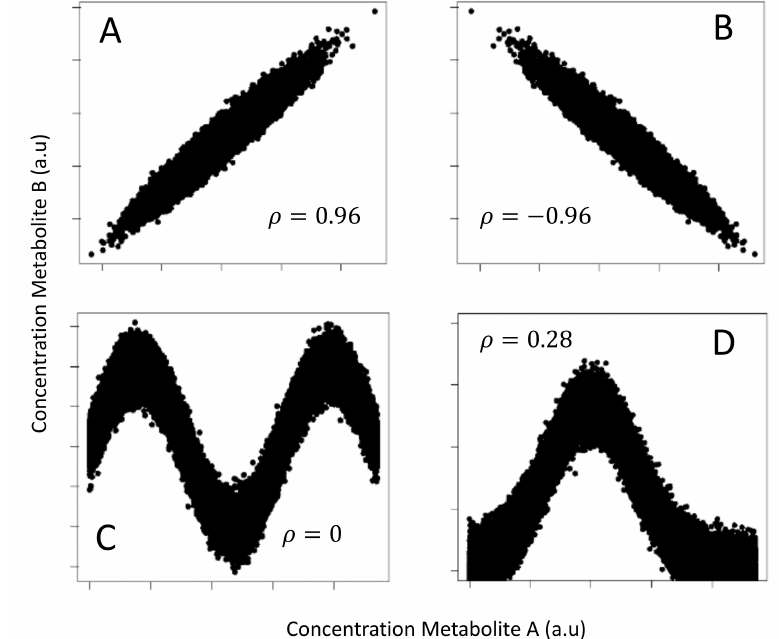
Figure 3. Four different data patterns obtained by plotting the simulated concentration of two metabolites, A and B , on which Gaussian experimental noise has been added. ( A ) Positive linear relationship, ρ = 0.96 (Pearson’s correlation); ( B ) Negative linear relationship, ρ = − 0.96; ( C ) Sine-wave relationship, ρ = 0 ; ( D ) Bell-shaped relationship, ρ = 0.28. In all cases, the MI is 1.32 nats (or 1.90 bits). One nat is the information content of the uniform distribution on the interval [ 0, e ] where e is the basis of the natural logarithm. This figure is an adaptation from Table 1 from Reference [13].